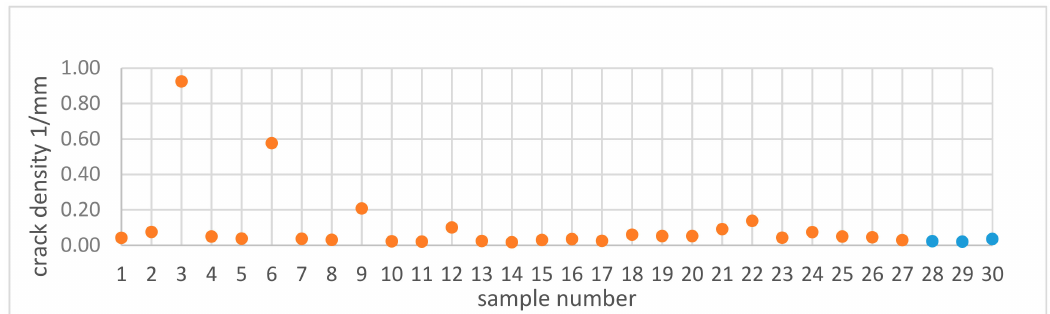
Figure 8. Crack density of samples manufactured by L-PBF (samples with varied parameters are in orange color, while replicates are in blue).